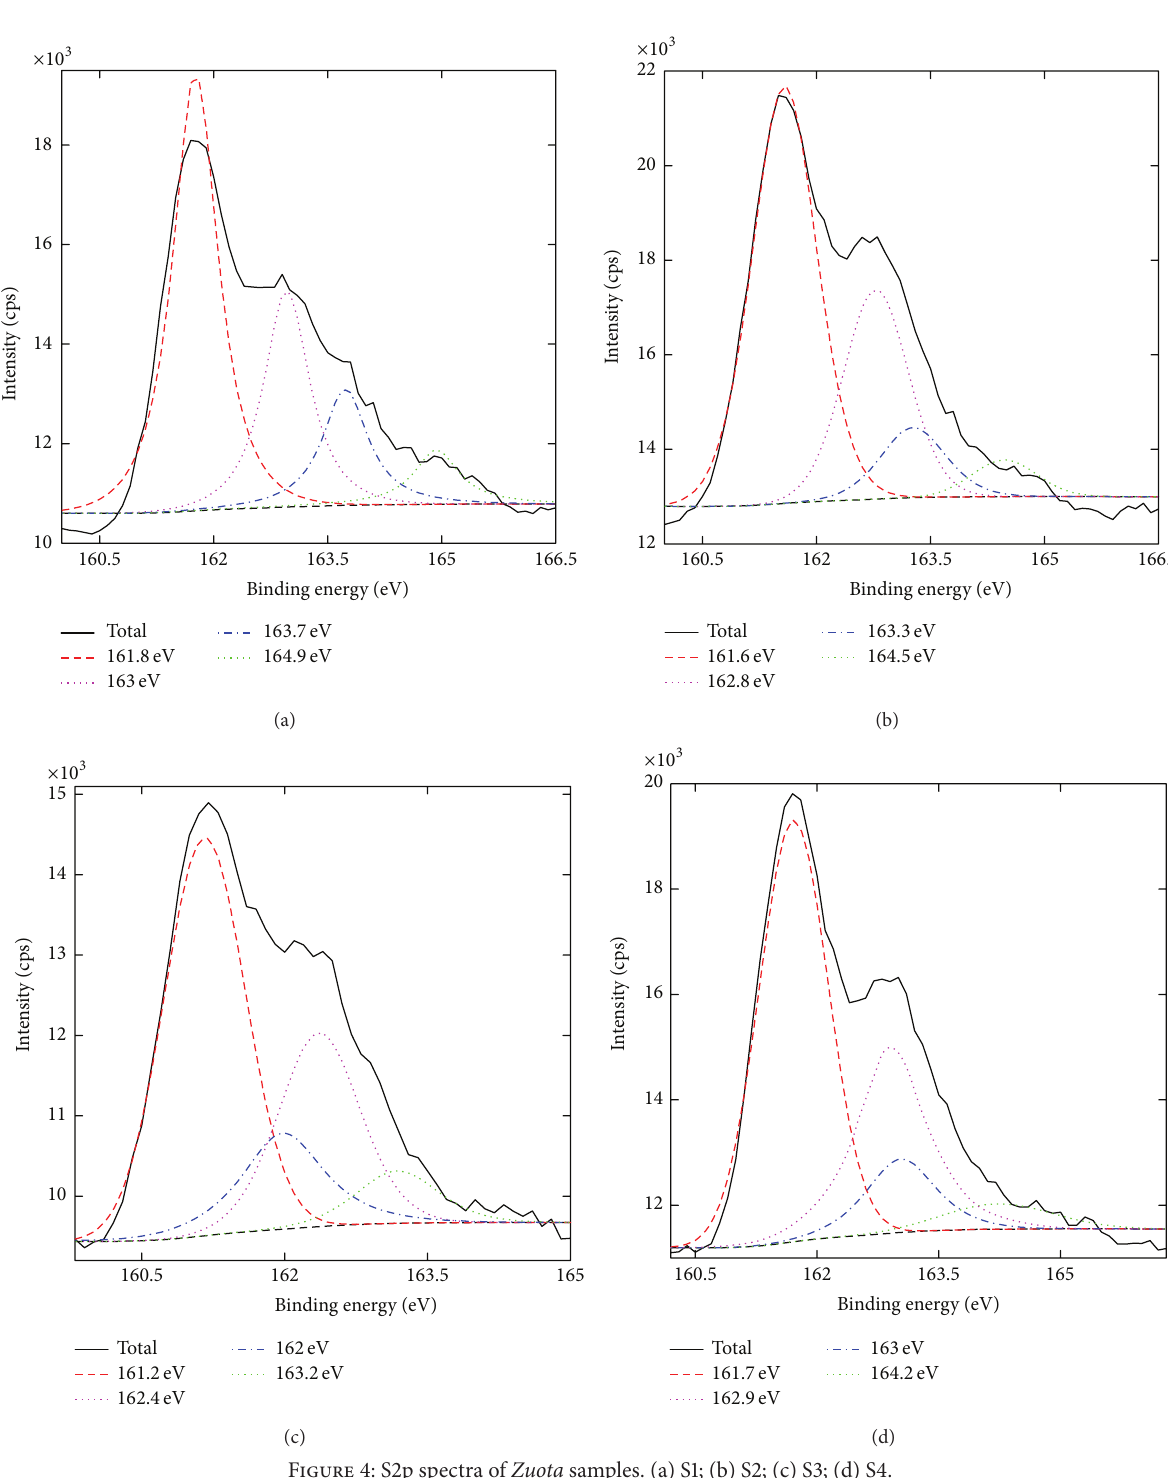
Figure 4: S2p spectra of Zuota samples. (a) S1; (b) S2; (c) S3; (d)